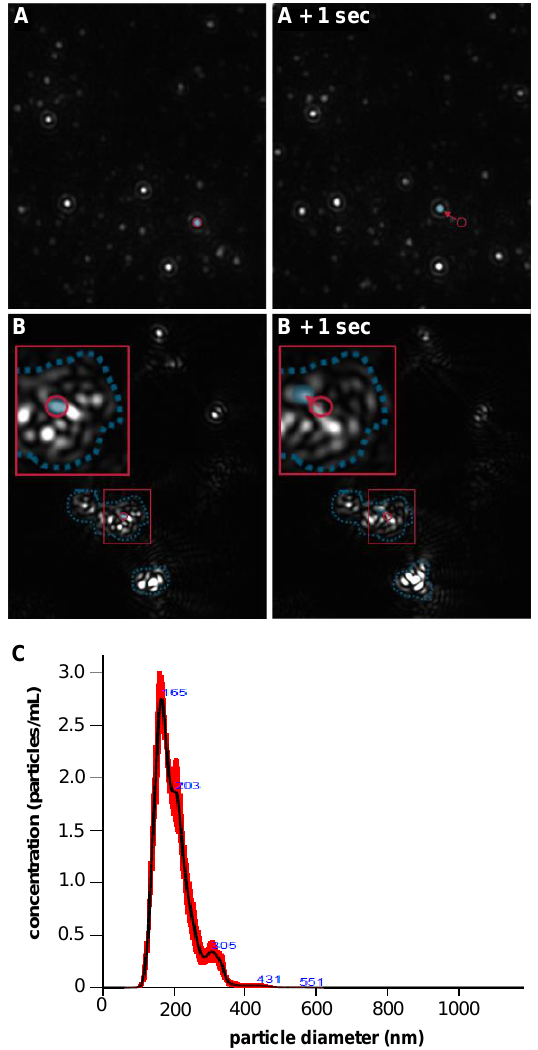
Figure 12. Single frames from microscopic light scattering videos (with same magnification) of samples Figure 12. Microscopic images of scattered light in 13.2 µg/mL BMP-2 containing samples during containing 13.2 µ g / mL BMP-2 during NTA in ( A ) MES bu ff er pH 5 and ( B ) PBS bu ff er pH 7.2. Red NTA in ( A ) MES buffer pH 5 and ( B ) PBS buffer pH 7.2. Red circles indicate individual intensity circles indicate individual intensity tracks. Blue dotted lines show large aggregates. ( C ) Mean NTA tracks. Blue dotted lines show large aggregates. ( C ) Mean NTA number size distribution ( n = 5) of number size distribution ( n = 5) of BMP-2 aggregates in MES bu ff er pH BMP-2 aggregates in MES buffer pH 5.